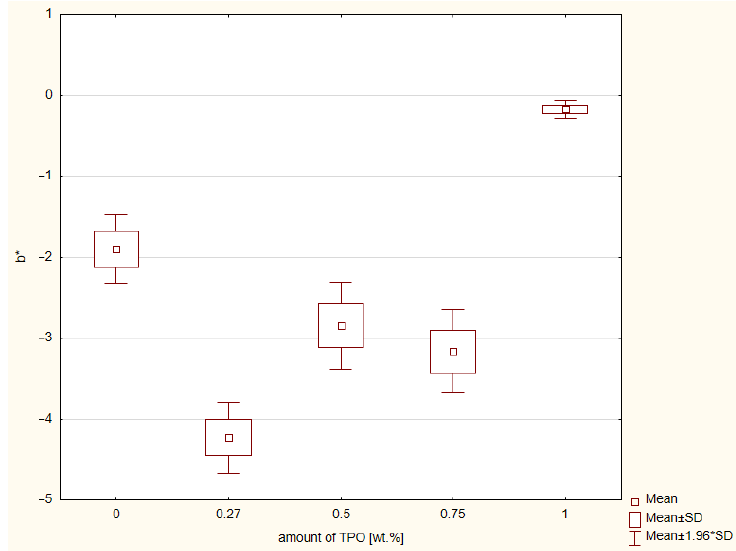
Figure 6. Box-and-whisker plot of results of color measurement CIE L* a* b* according to the axis b* of experimental composites containing different concentration of TPO and the control group CQ and DMAEMA; photopolymerization both side of samples 20 s. per 2 mm thickness of composites with Valo lamp light intensity 1450 mW/cm 2 .